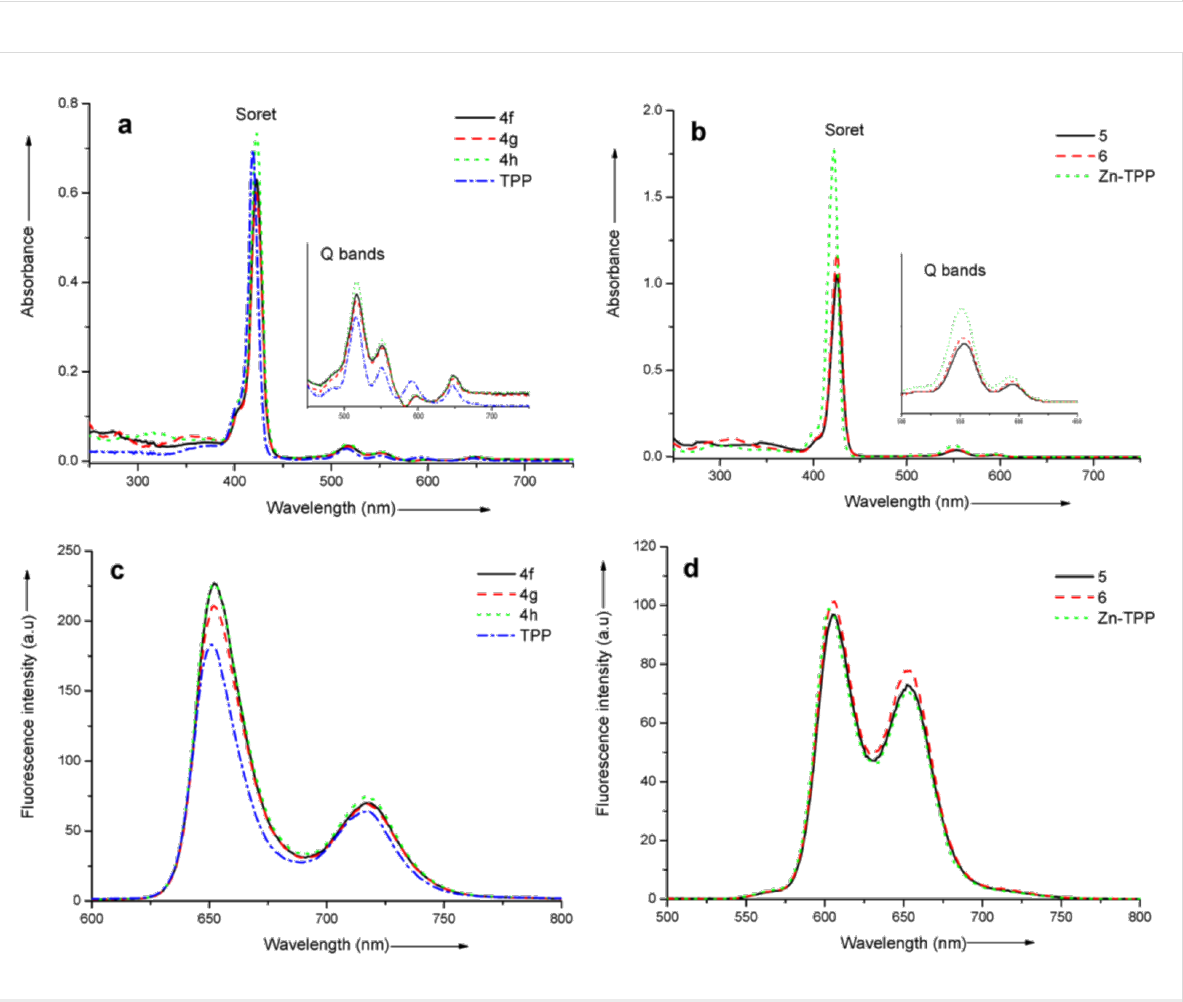
Figure 1: (a) Electronic absorption spectra of free-base porphyrins 4f , 4g , 4h and TPP in CHCl 3 (1 × 10 − 6 mol L − 1 ) at 298 K. (b) Electronic absorp- tion spectra of zinc porphyrins ( 5 , 6 and Zn–TPP) in CHCl 3 (2 × 10 − 6 mol L − 1 ) at 298 K. The inset in both (a) and (b) shows the Q bands. (c) Fluores- cence spectra of porphyrins 4f , 4g , 4h and TPP in CHCl 3 (1 × 10 − 6 mol L − 1 ) at 298 K, λ ex = 420 nm. (d) Fluorescence spectra of zinc porphyrins ( 5 , 6 , and Zn–TPP) in CHCl 3 (2 × 10 − 6 mol L − 1 ) at 298 K, λ ex = 420